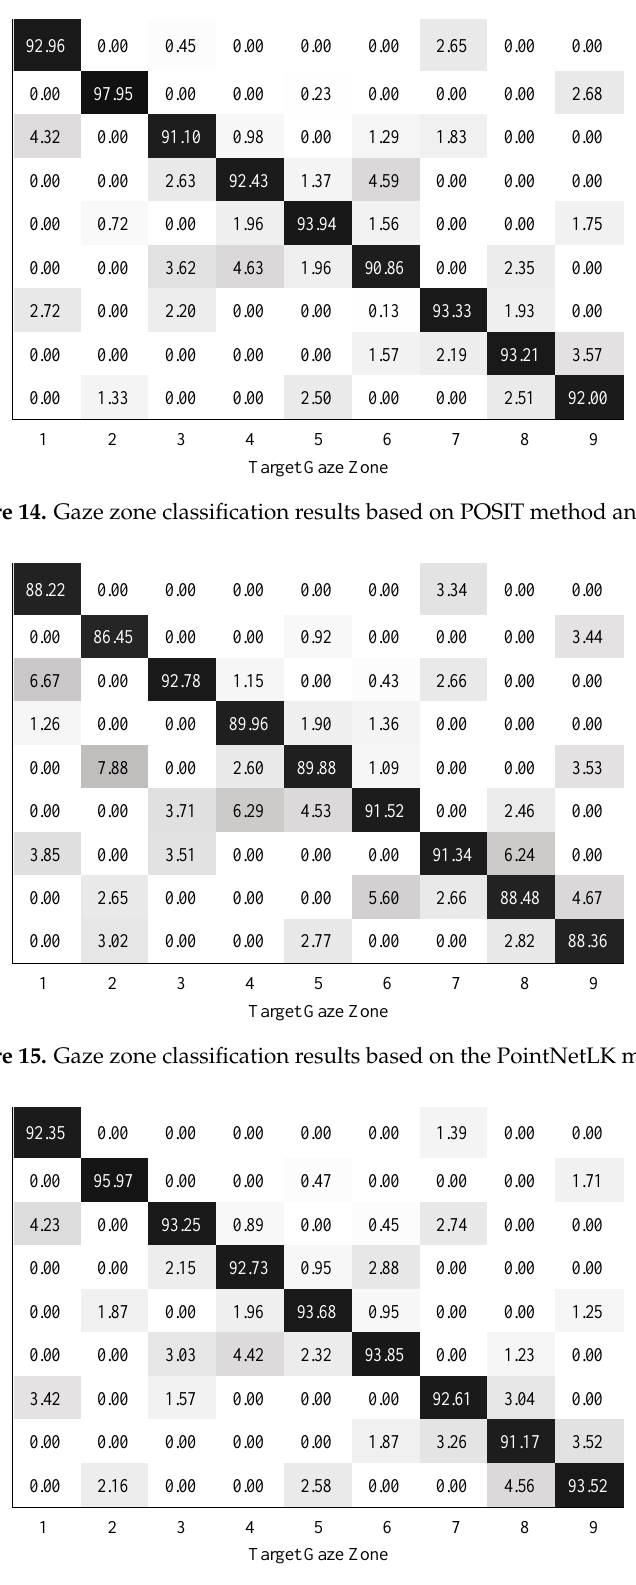
Figure 16. Gaze zone classification results based on the proposed method and NN